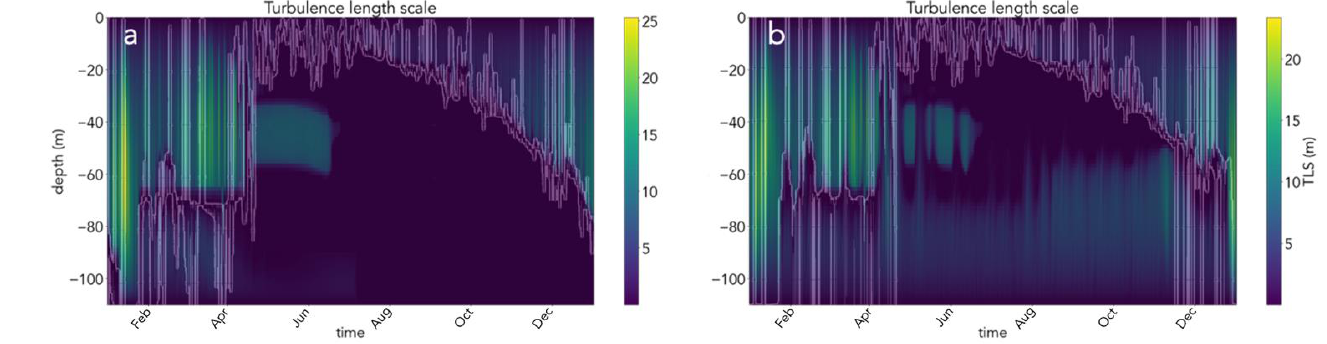
Figure 8. TLS (m) and surface mixed layer (SML) depth in 2 scenarios: ( a ) without tides, ( b ) with tides (the water column stays stratified during summer season).